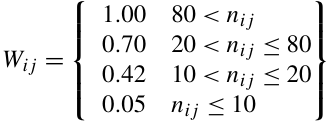
The weekly NH 3 concentration across all heights averaged 13 . 3 ± 4 . 8 µg m − 3 during the year-long study period. Individ- ual weekly concentrations ranged from 4.4 µg m − 3 at 2 m to 25.3 µg m − 3 at 32 m. Nearly all (99.6 %) of the weekly NH 3 concentrations along the profile exceeded 5 µg m − 3 . Summer concentrations were generally the highest. Maximum NH 3 concentrations mostly occurred between 32 and 63 m, de- creasing both towards the surface and the top of the tower. Minimum concentrations mostly occurred at 2 and 320 m (Fig. S1 in the Supplement). Significant differences of annual average NH 3 concentrations across the vertical profile were only found between the “maximum concentration” height and the top two heights, i.e., 280 and 320 m (Fig. 3i). Even at 320 m, the annual average NH 3 concentration was still relatively high at 11.3 µg m − 3 (Fig. 3i). During the whole observation period, the daily average boundary layer height was generally above 320 m, indicating that a good portion of the sampling occurred within a well-mixed boundary layer (Fig. S2). Seasonal vertical concentration profiles exhibited fairly similar shapes to the annual average profile, although there were some important differences in absolute concentration values and the magnitude of vertical gradients within the profiles (Fig. 3). The average NH 3 concentration across the profile from high to low was observed in